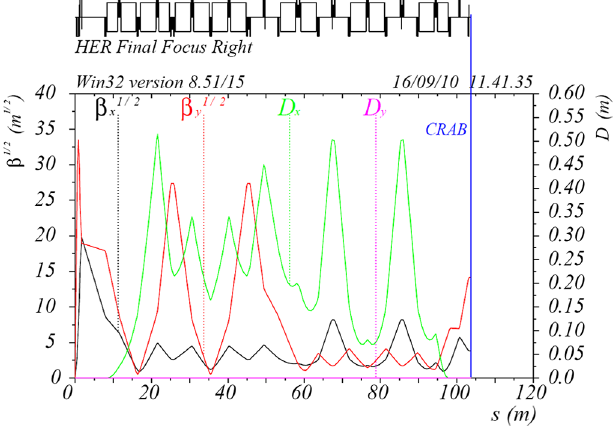
FIG. 7. Optical functions of SuperB HER interaction region with crab waist sextupoles.